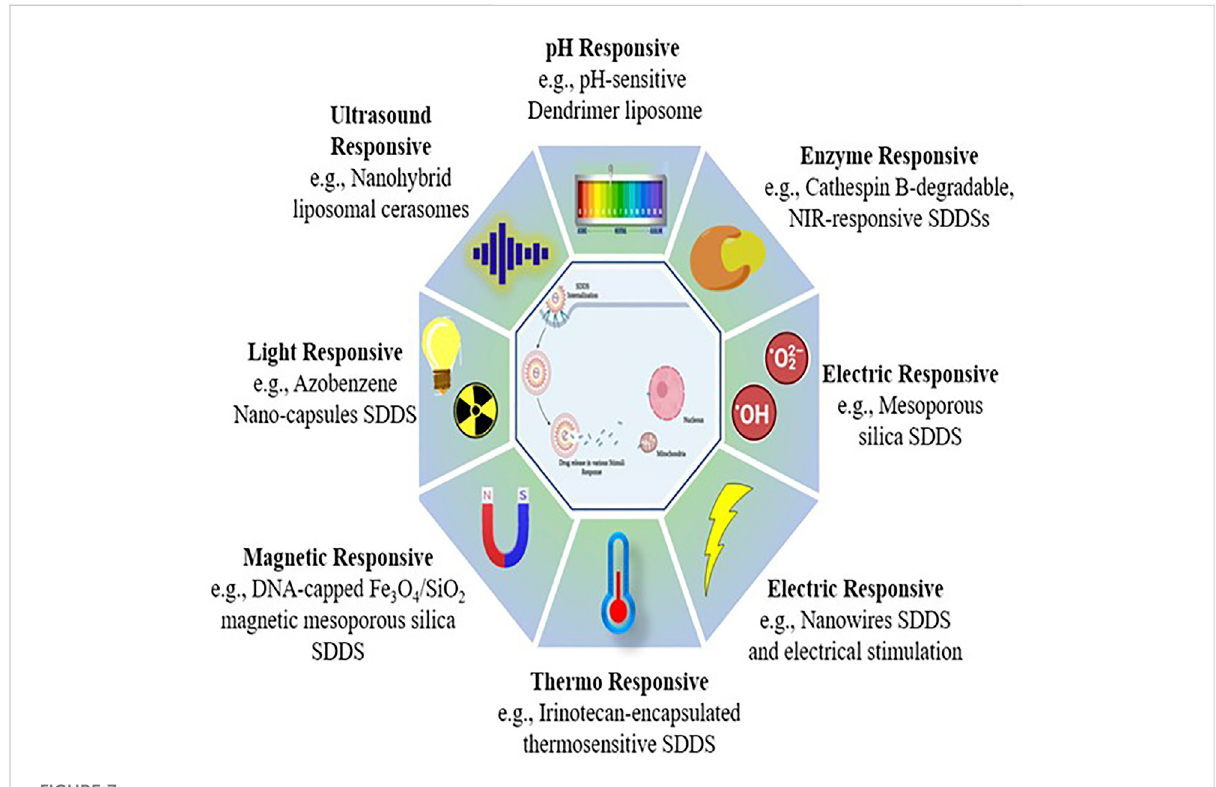
FIGURE 7 Stimuli responsive smart drug